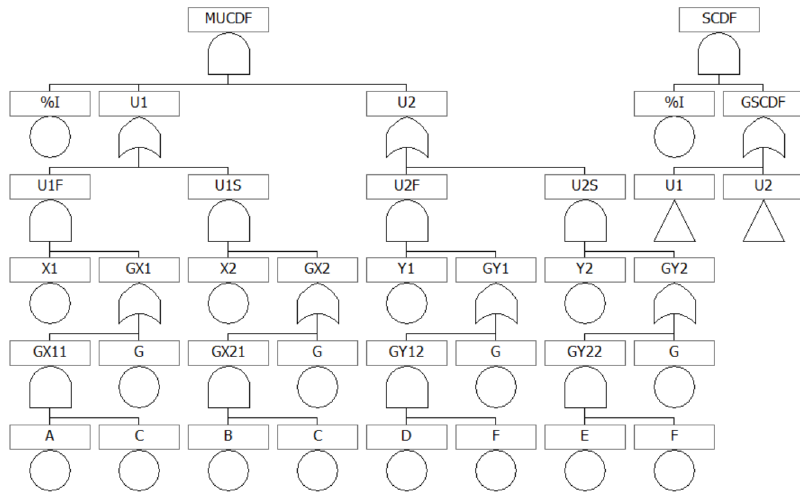
Figure 3. Multi ‐ unit core damage frequency (MUCDF) and site core damage frequency (SCDF) fault trees with partitioning events.